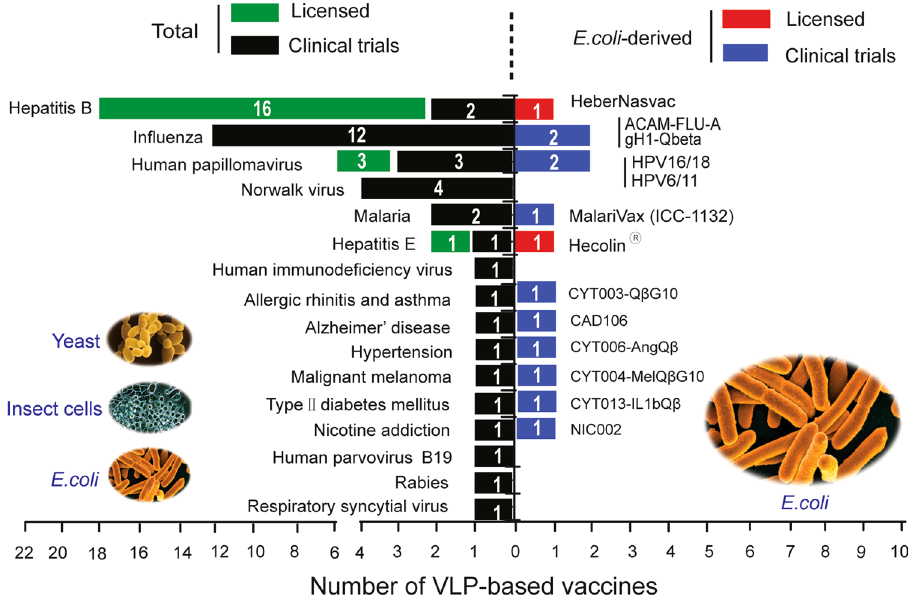
Fig. 1 The number of VLP-based vaccines or vaccine candidates that were approved and in clinical studies from 1986 to 2015. Total numbers of VLP vaccines or candidates derived from different expression systems (including E. coli ) are plotted on the left. The numbers of commercialized VLP vaccines or those being tested in clinical trials derived from E. coli are plotted on the